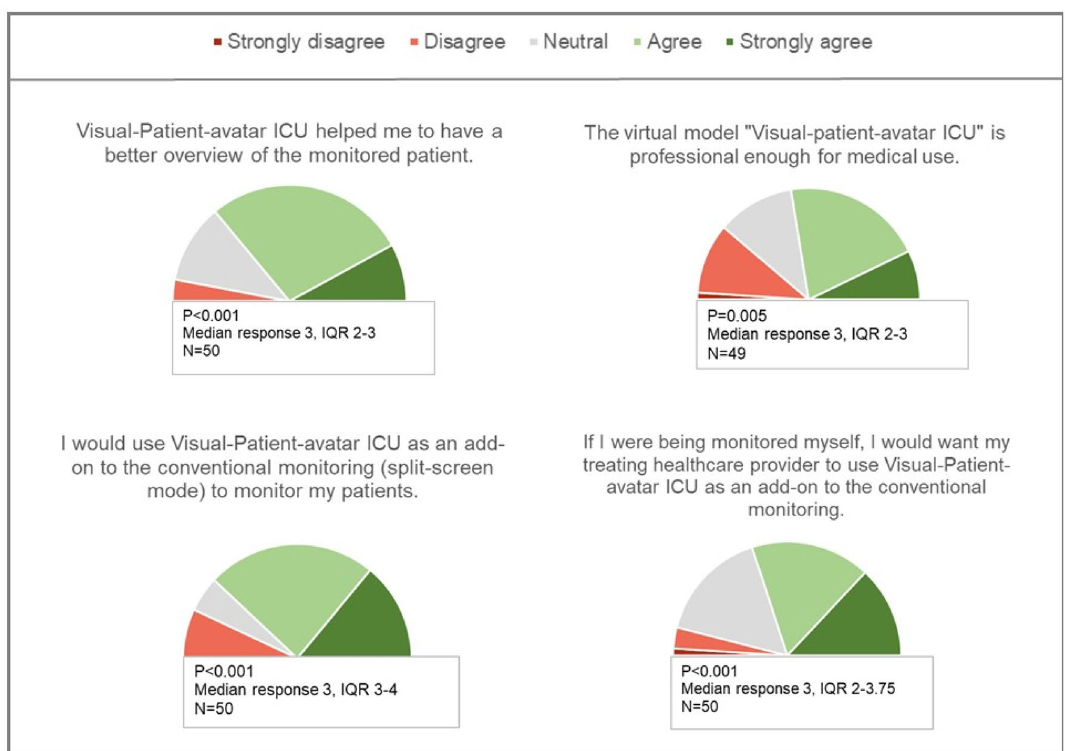
Figure 5. Graphical display of the participants’ assessment concerning the four general statements as half pie charts. Results are shown as median and interquartile range (IQR). We used Wilcoxon signed-rank test to determine whether the answers differ from neutral (P <